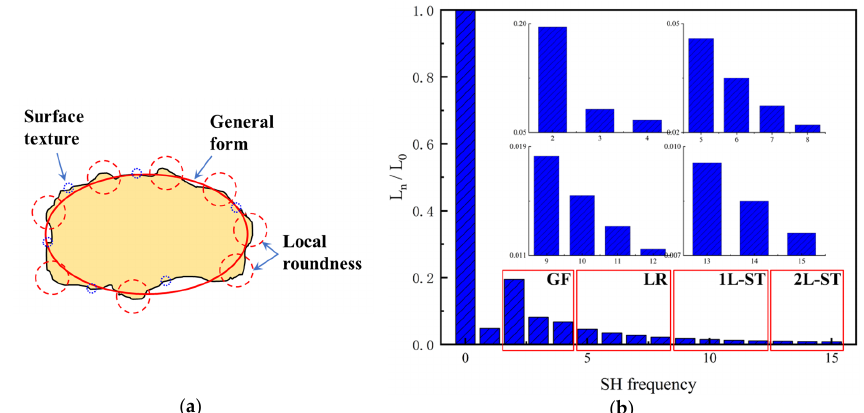
Figure 2. Particle morphology at different relative length scale (RLS): ( a ) schematic diagram; ( b ) averaged second-order norms for each spherical harmonic (SH) frequency.